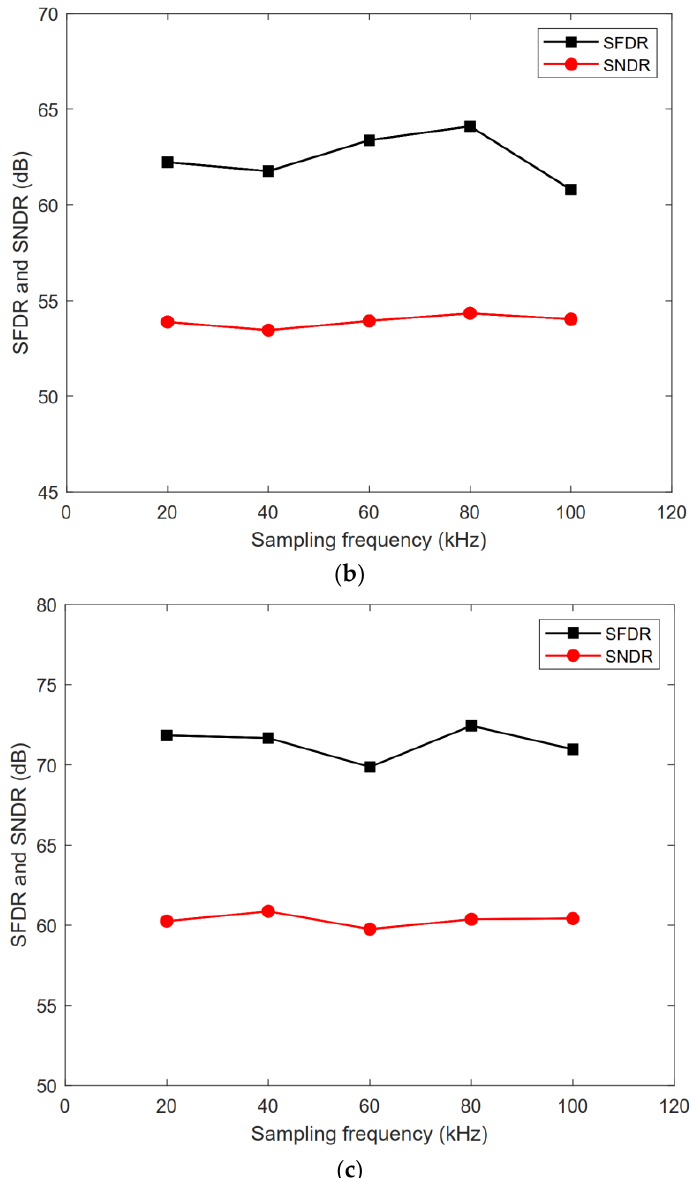
Figure 19. SNDR/SFDR with various sampling frequencies: ( a ) 8-bit mode; ( b ) 9-bit mode; ( c ) 10-bit mode.